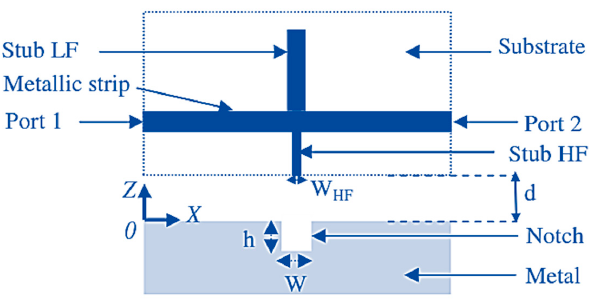
Figure 8. Schematic of the first-order DBR probe (from [29]; copyright © 2008; redesigned with permission).